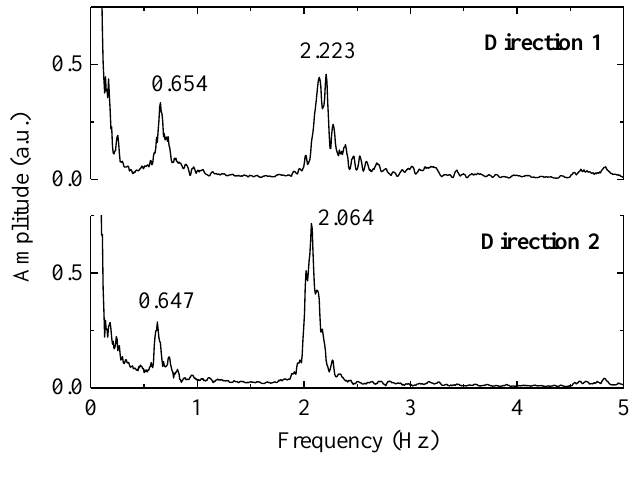
Figure 10. Frequency spectra obtained from the acceleration data recorded in the tower, when subjected to the wind